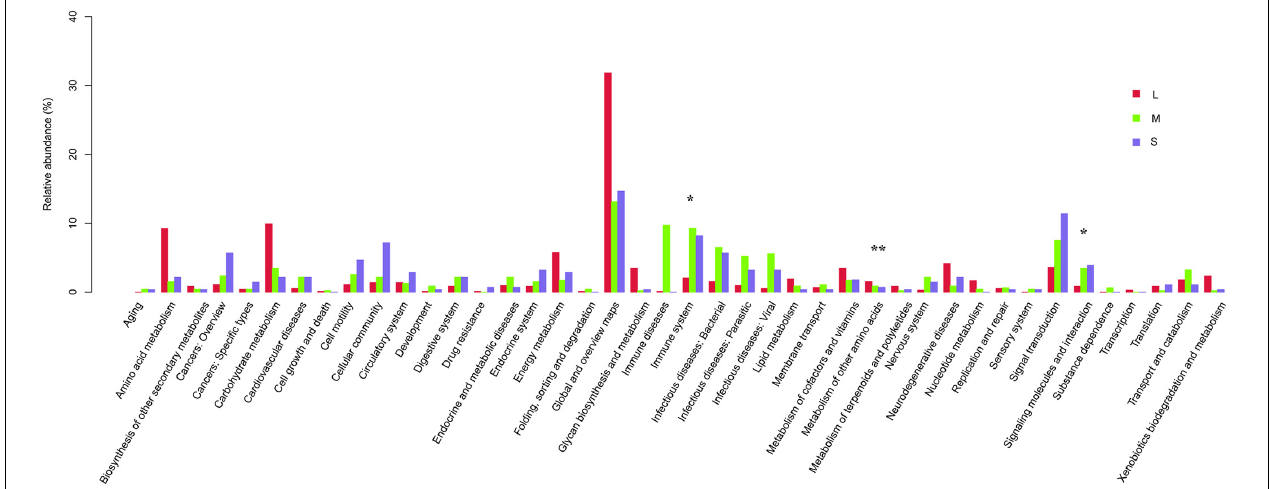
FIGURE 8 | Comparison between the enriched KO markers at level 2 of the KEGG functional category for yellowfin sea bream. * means P < 0.05 and ** means P < 0.01.